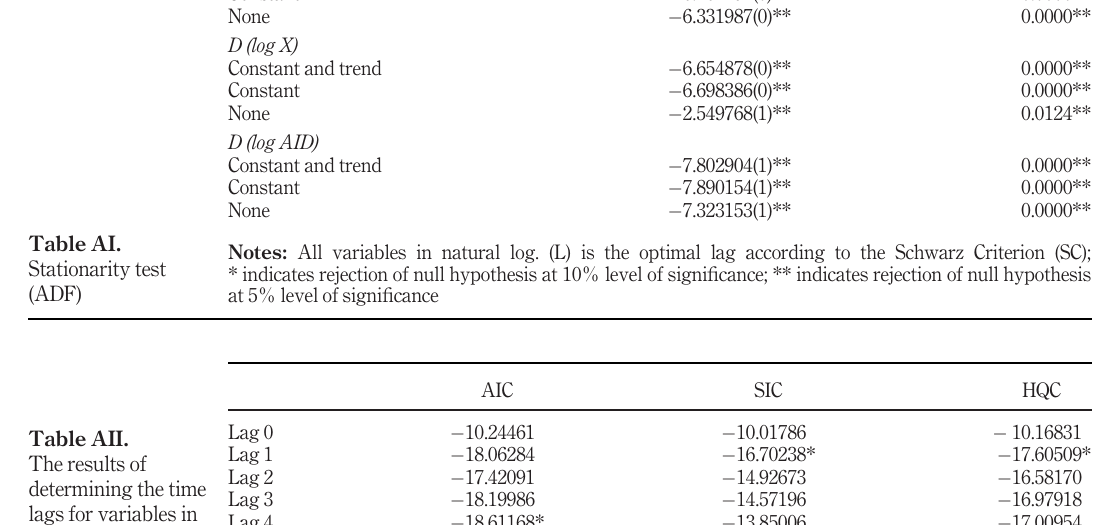
Table AII. The results of determining the time lags for variables in India during the period